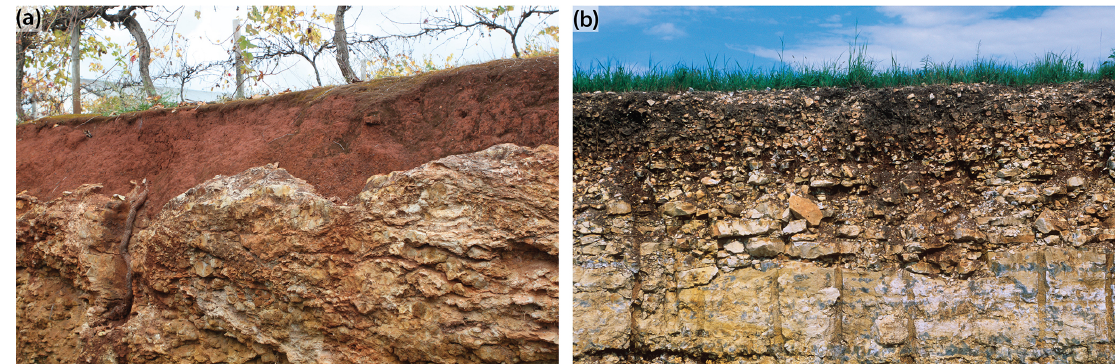
Figure 1. Weathering can be focused at different depths below surface. (a) Australia. Weathering focused mainly at the sharp regolith– bedrock interface. The soil consists mostly of residuum from the limestone bedrock together with aeolian dust. (b) Kansas, USA. Clasts released from the limestone bedrock at Flint Hills gradually decrease in size towards the surface. No clear regolith–bedrock interface is visible, indicating that weathering likely concentrates within the regolith.